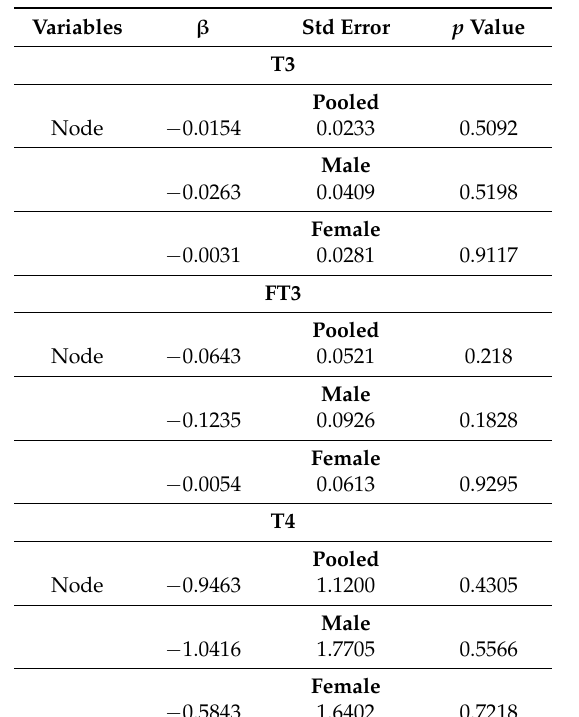
Table 3. Multiple linear regression * to estimate the correlation of thyroid nodules with thyroid hormones and autoantibodies among adults,